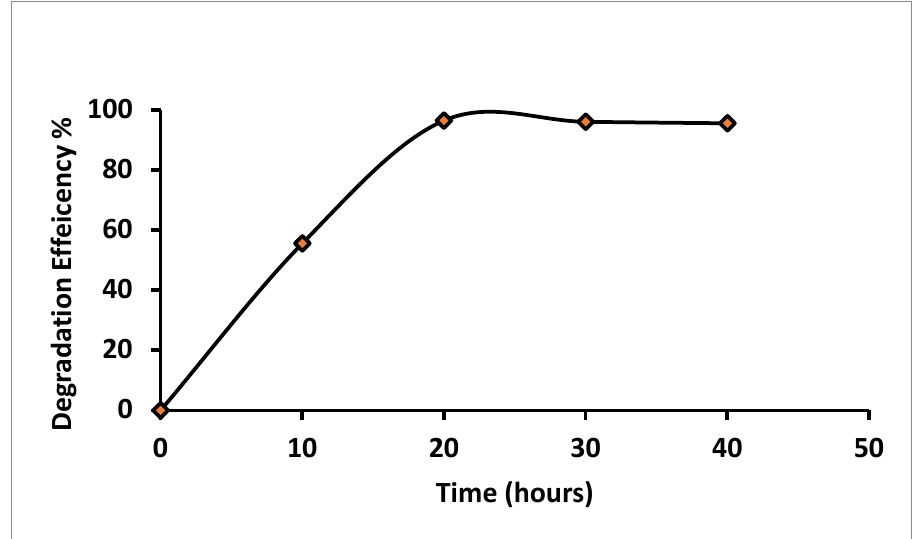
Figure 6. Degradation efficiency of green TiO 2 under UV irradiation.